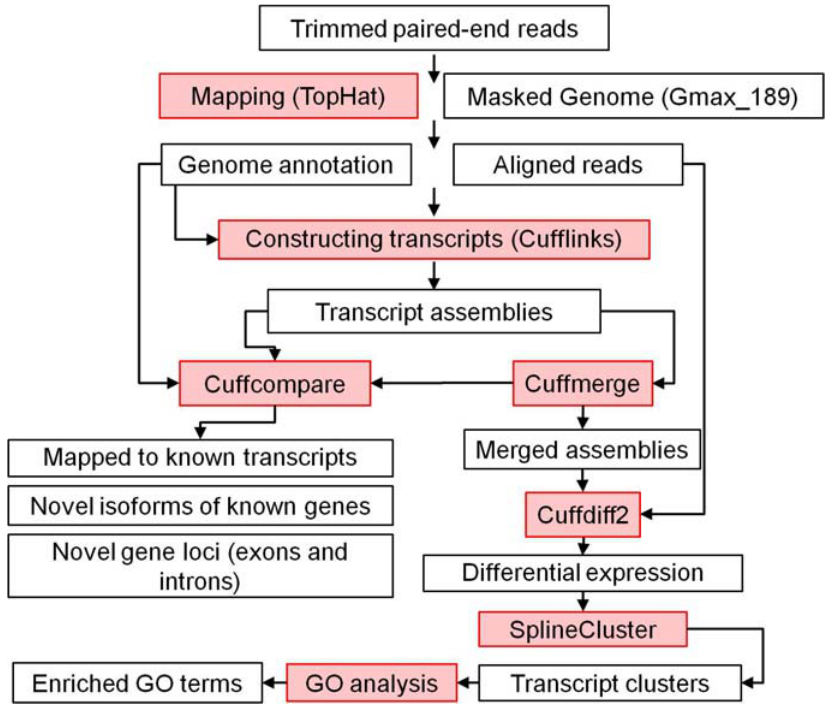
Figure 5. RNA sequencing, differential expression, and coexpression pipeline. Computational tools are shown in